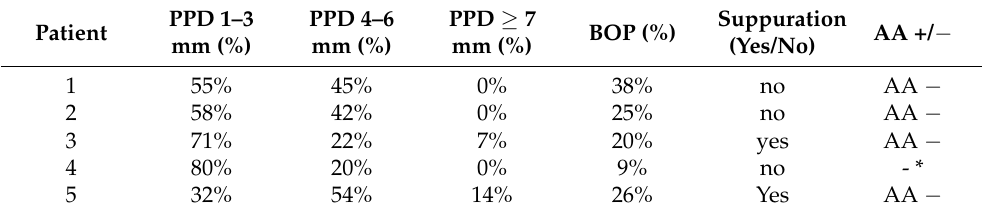
Table 2. Clinical data: probing pocket depths (PPD), bleeding on probing (BOP), suppuration, and microbiological findings at last